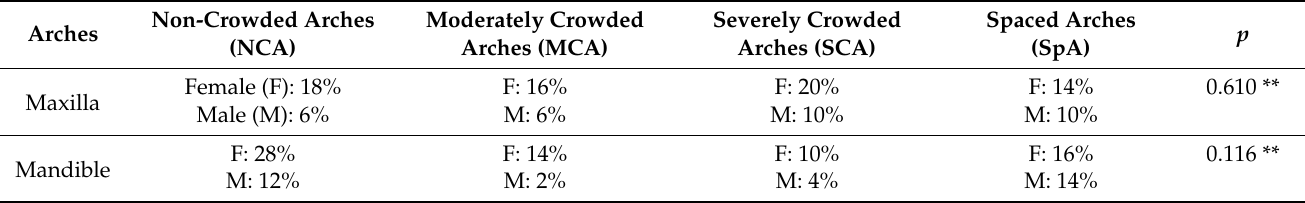
Table 2. Distribution of crowded, non-crowded, and spaced arches in the study group related to gender; not significant differences according to chi-square